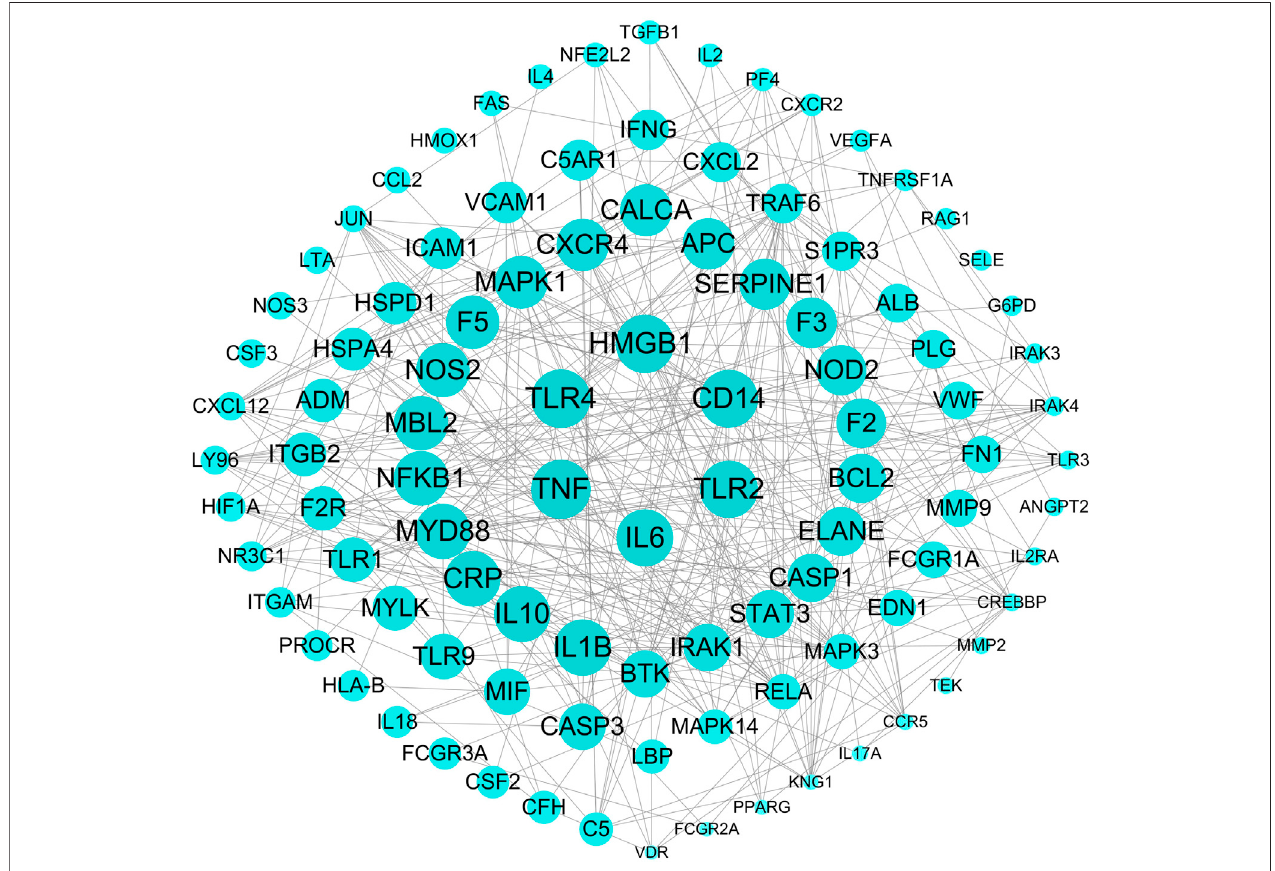
FIGURE 3 | The top 100 weighted gene regulatory network of sepsis. The node size represents the weight of the genes in the network.